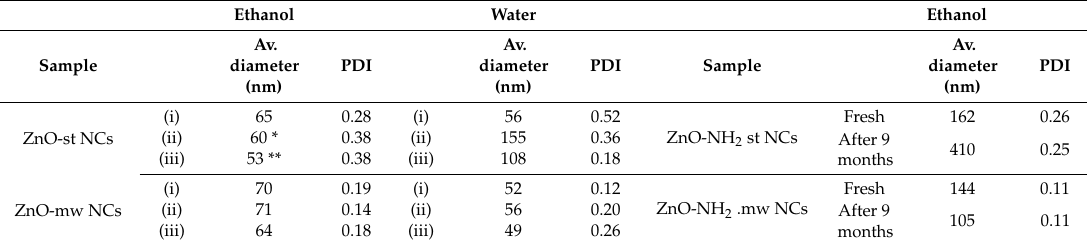
Table 1. Polydispersity indexes (PDI) and average diameter of number-weighted distributions of pristine ZnO NCs obtained via traditional synthesis (ZnO-st NCs) and via microwave route (ZnO-mw NCs) in ethanol and water and of functionalized ZnO particles (ZnO-NH 2 -mw and ZnO-NH 2 -st) in ethanol just after the functionalization procedure and after nine months of